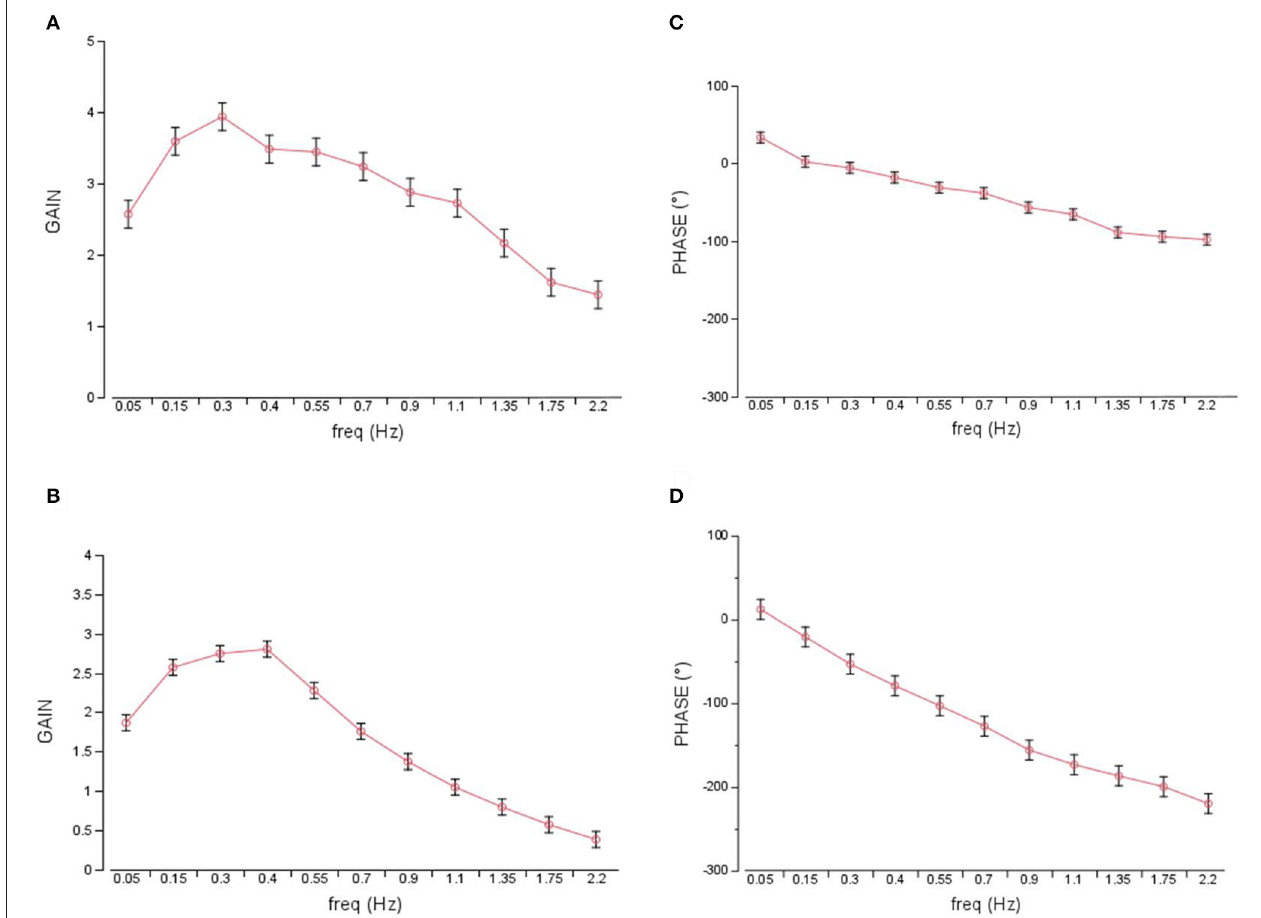
FIGURE 3 | GAIN and PHASE curves representing transfer functions of virtual balancing and free stance. GAIN during virtual balancing (A) , and during free stance (B) across all parameter settings, freq, frequency in Hz. Respective PHASE (in degree) during virtual balancing (C) and during free stance (D)